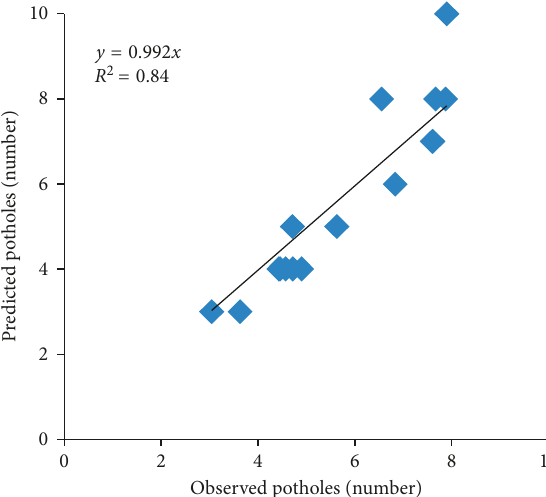
Figure 20: Scatter plot between observed versus predicted total cracking for validation (2015).